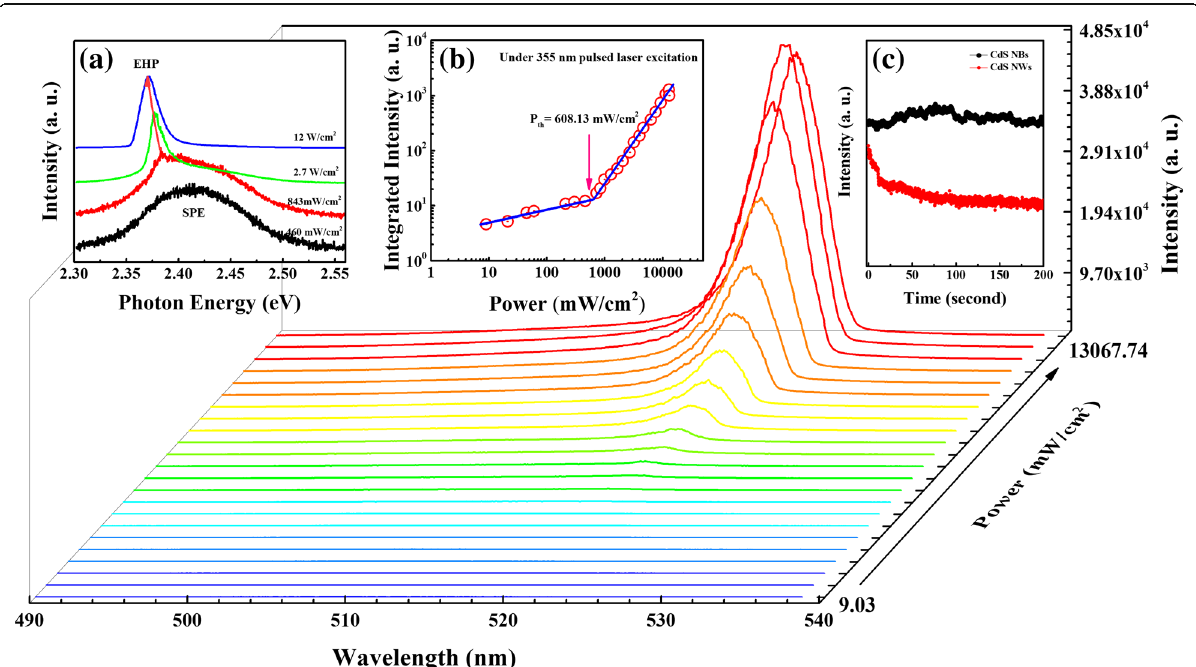
Fig. 5. Power-dependent lasing spectra of CdS NBs at room temperature, the inset a shows the trend of lasing emission peak, the inset b is integrated peak intensity as a function of excitation power, and the inset c represents the PL intensity of CdS NBs and NWs plots as a function of time, both samples excited under 355 nm pulsed laser with the power density of 12.8 W/cm